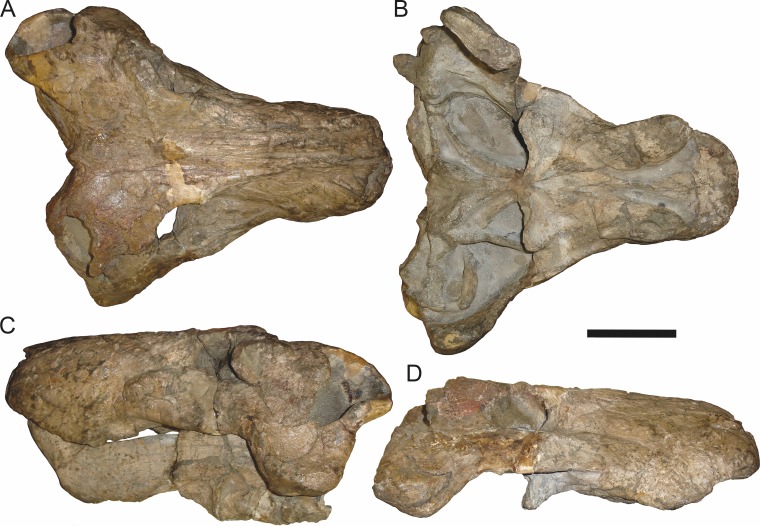
Referred specimen (BP/1/803) of Leontosaurus vanderhorsti
Broom & George, 1950 in (A) dorsal, (B) ventral, (C) left lateral, and (D) right lateral view.Holotype of Rubidgea platyrhina
Brink & Kitching, 1953. Scale bar equals 10 cm.